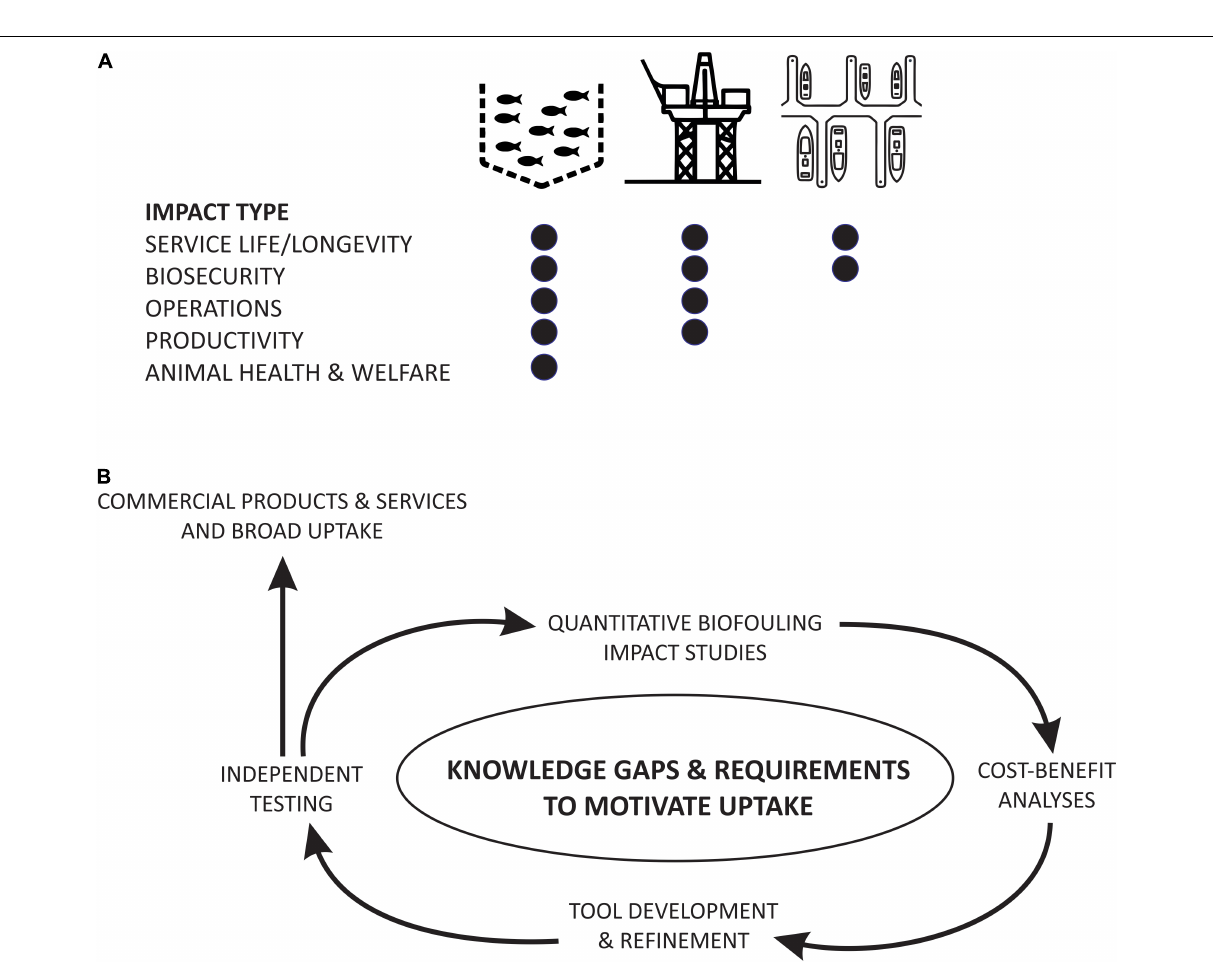
FIGURE 2 | (A) Impact types assigned to the categories of SSAS focused on in this review: aquaculture, energy production, and port and marina infrastructure, and (B) knowledge gaps and requirements to facilitate or motivate the uptake of existing and emerging biofouling management tools. Impact types assigned in panel (A) are based on normal operations and could change during a biosecurity response (e.g., closure of a marina for